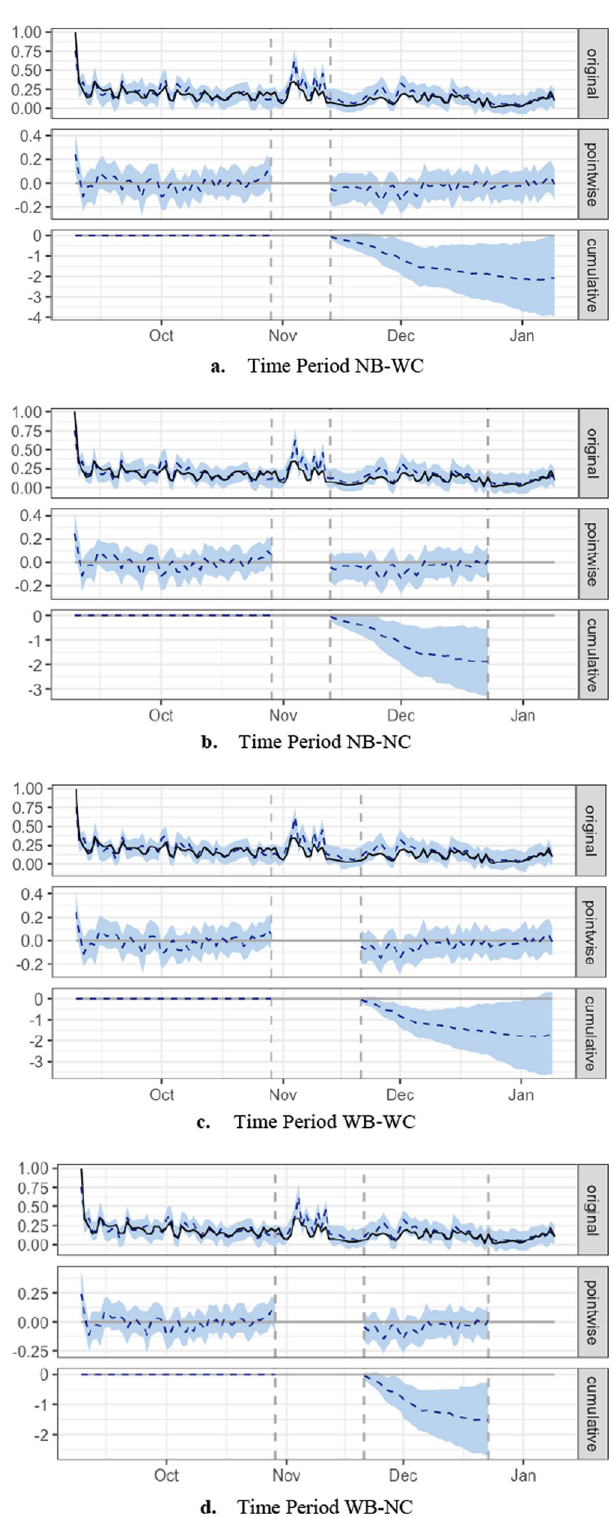
Fig. 3 CausalImpact graphs for System